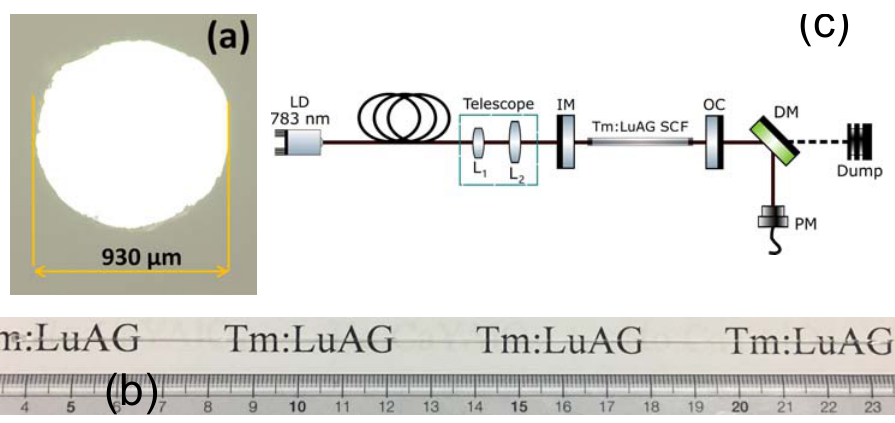
Figure 1. End facet of Tm:LuAG SCF ( a ) as-grown Tm:LuAG SCF ( b ) and schematic of the CW Tm:LuAG SCF laser pumped by a 783-nm laser diode ( c ), IM, input mirror; OC, output coupler; DM, dichroic mirror; PM, power meter.